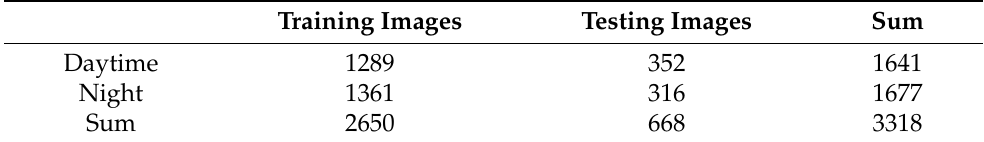
Table 1. The composition of the infrared and visible image dataset.